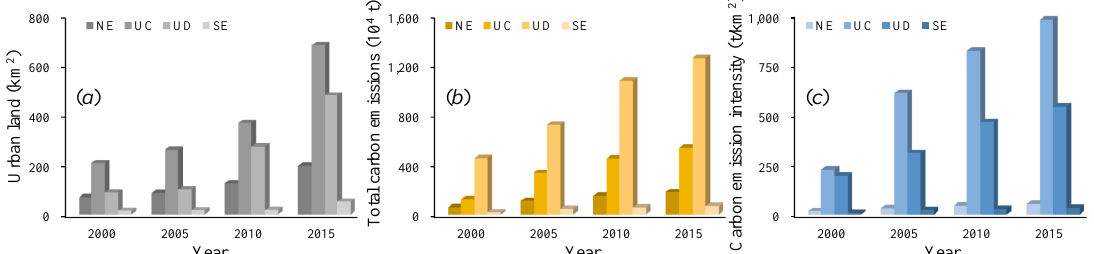
Figure 4. Urban land and carbon emissions at the regional scale in Chongqing from 2000 to 2015. Note: ( a ) urban land; ( b ) total carbon emissions; ( c ) carbon emission intensity.